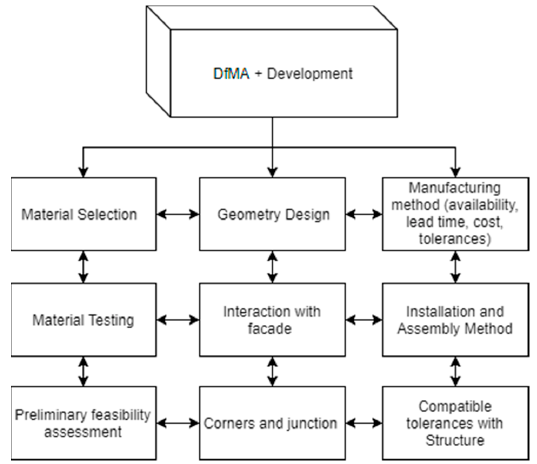
Figure 12. The DfMA (Design for Manufacture and Assembly) and Development process.